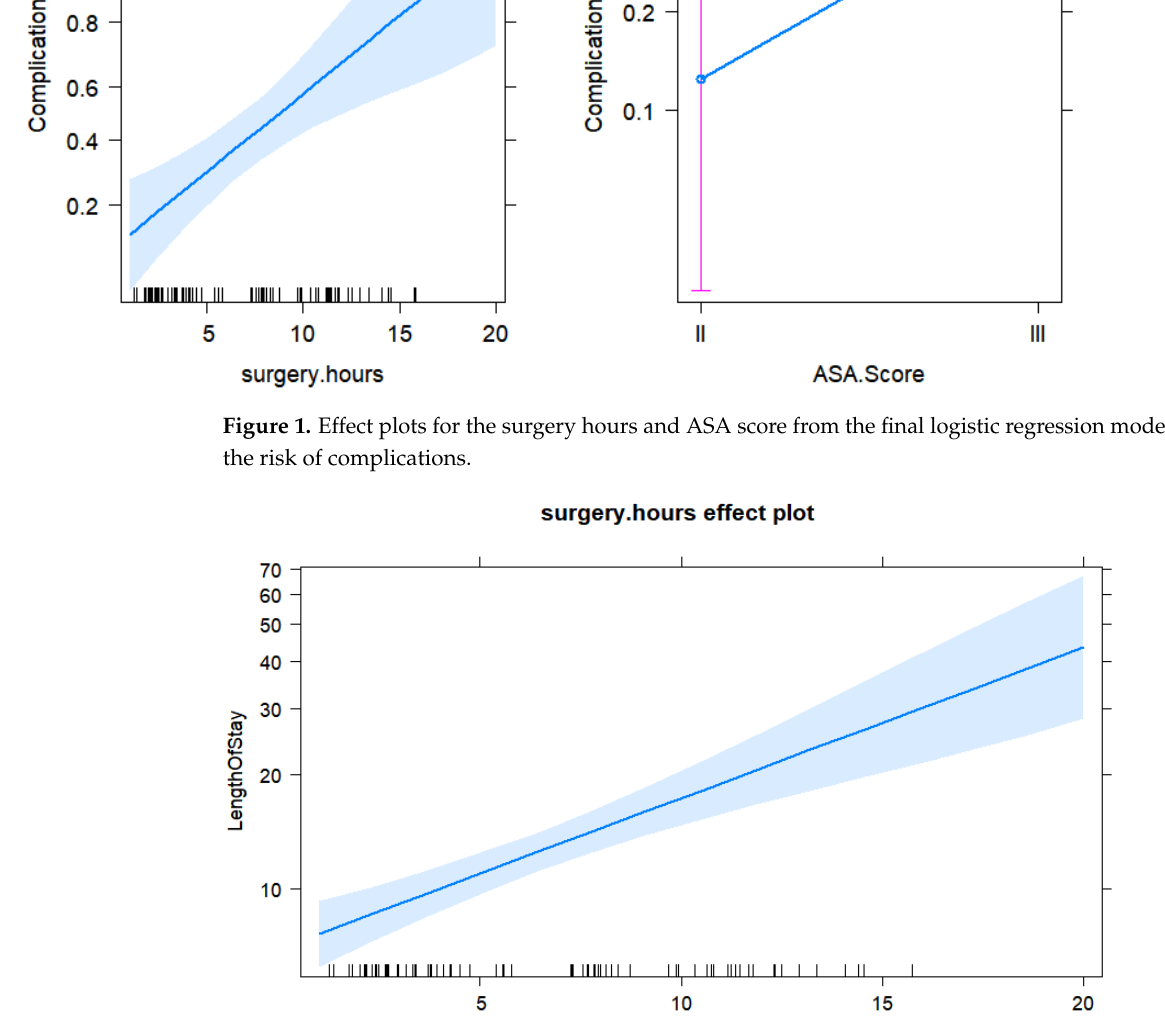
Table 5. Initial ( A ) and final ( B ) Gamma generalized regression model for the length of stay. (A) Initial model for the length of stay